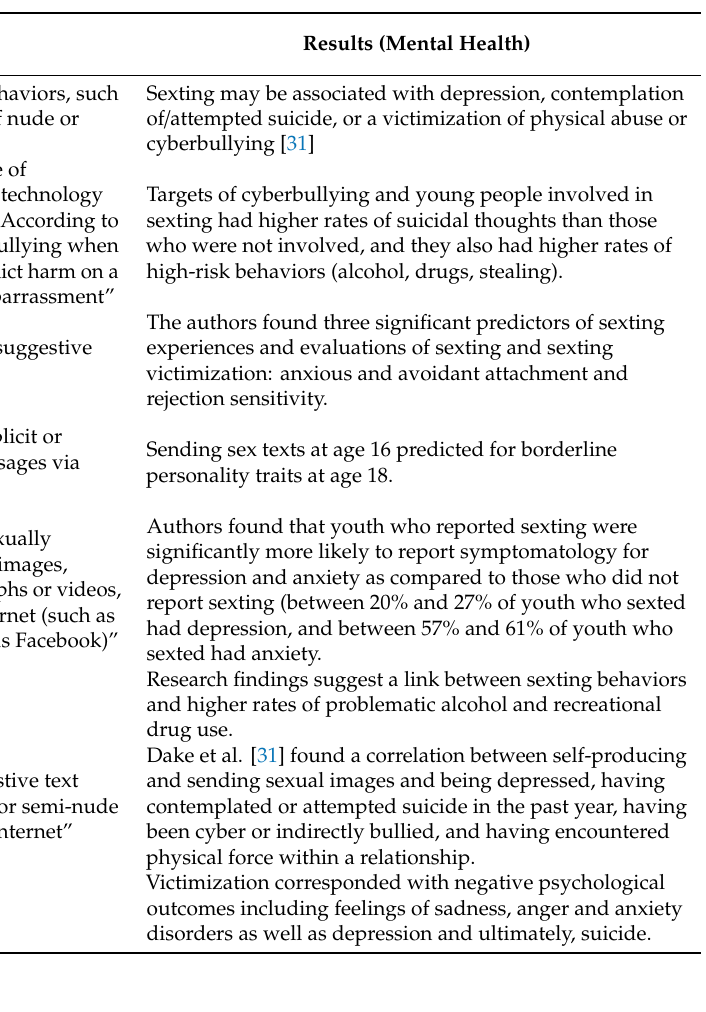
Table 1. Details of studies included in the